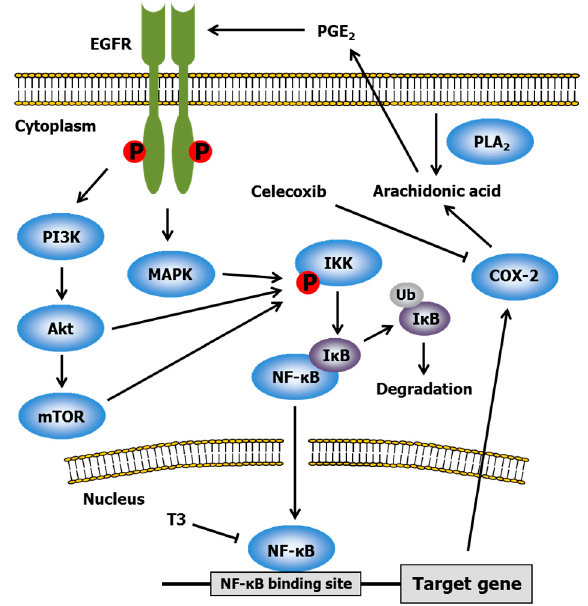
Figure 4. Crosstalk between EGFR and nuclear factor- κ B (NF- κ B) signaling pathway. PGE 2 , prostaglandin E 2 ; I κ B, inhibitors of κ B; IKK, I κ B kinase; COX-2, cyclooxygenase-2; mTOR, mammalian target of rapamycin; Ub, ubiquitylation; PLA 2 , phosphorlipase A 2 ; P, phosphorylation. Arrows and perpendicular lines indicate activation/induction and inhibition/suppression, respectively.